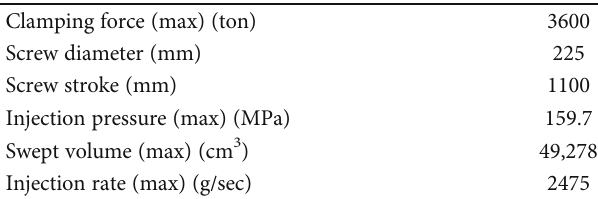
Table 3: Chen Hsong Supermaster 3600E1 speci fi